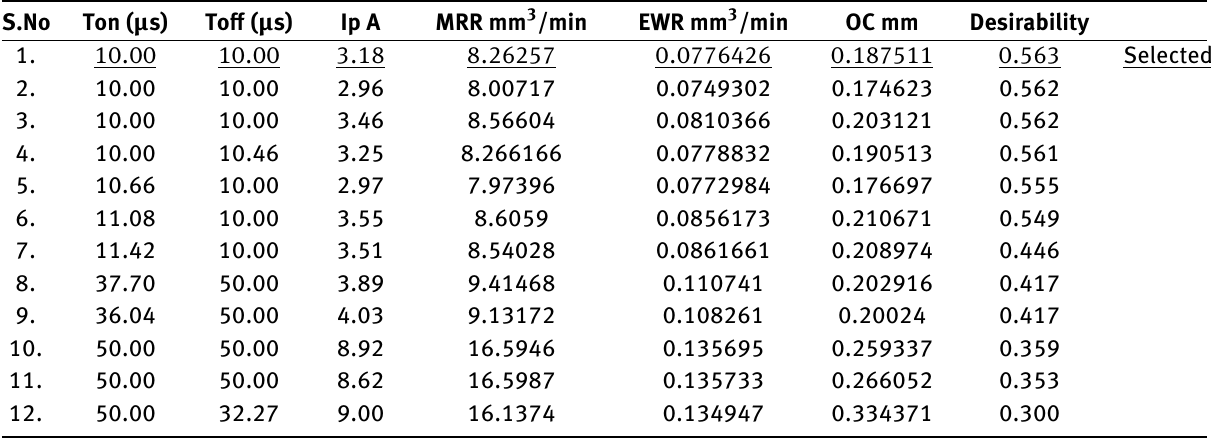
Table 8: Multi Response Optimization through desirability function